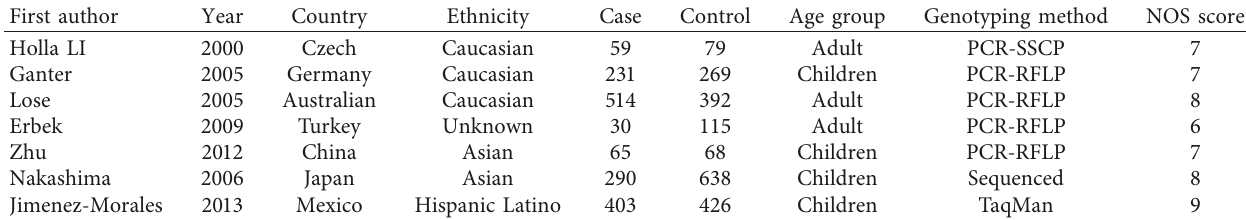
Figure 1: The flow diagram of inclusion of studies in meta-analysis. Table 1: Characteristics of the studies included in the meta-analysis.